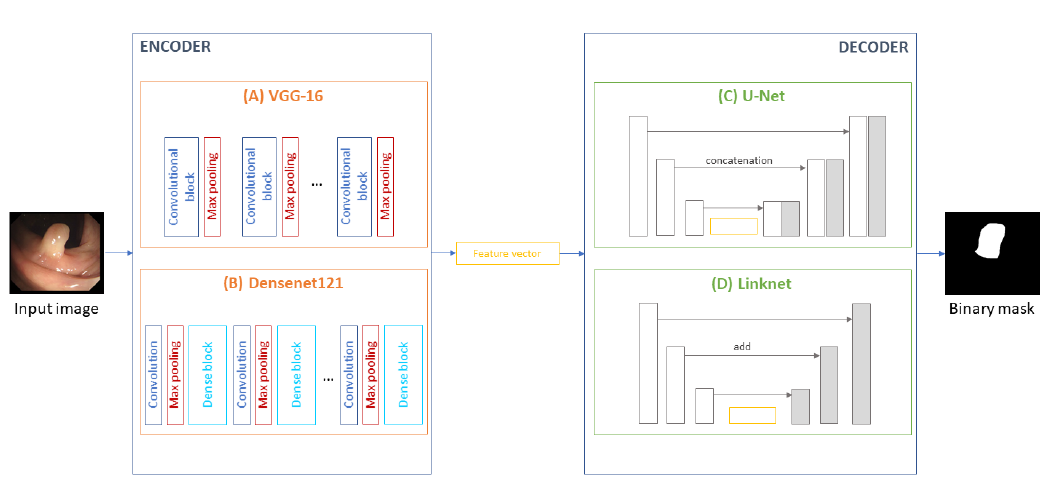
Figure 3. Models considered in this work are obtained by combining one backbone for the encoder ( A , B ) with one encoder-decoder architecture ( C , D ). Image reproduced from [34].